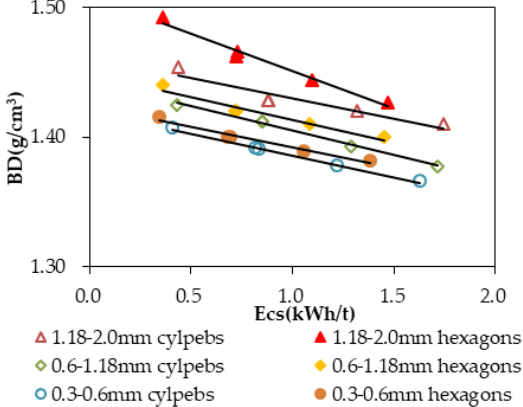
Figure 10. Relationship between specific surface area and specific energy.